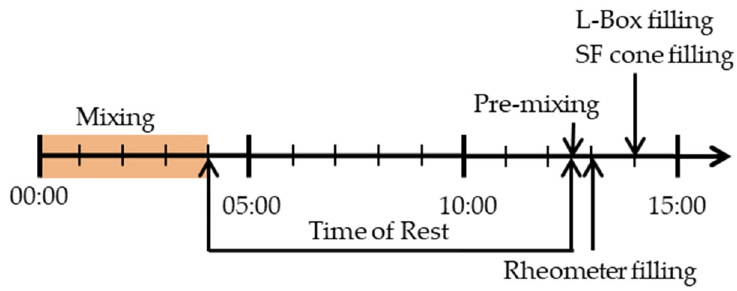
Figure 2. Test procedure from the moment of water addition until the start of rheometric measurements 15:00 min after water addition.